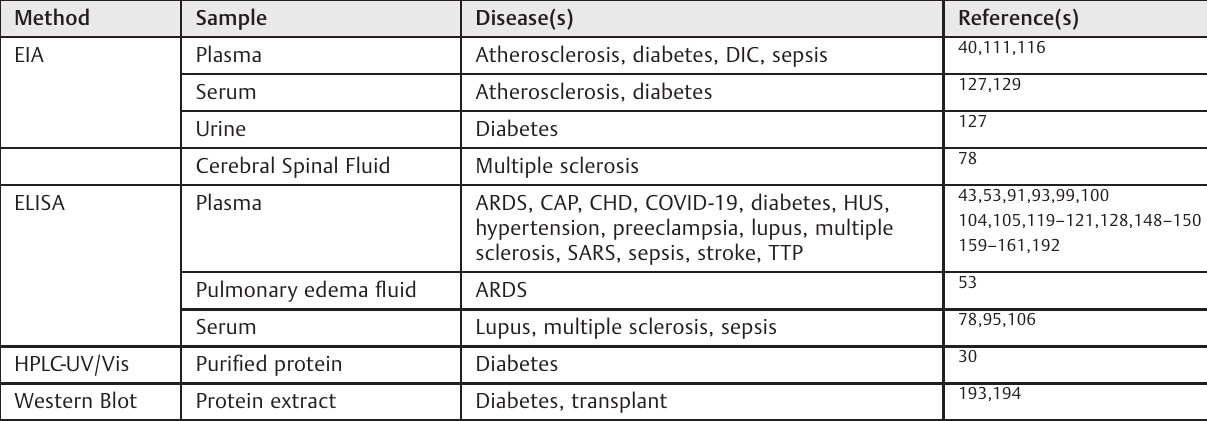
Table 2 Methods for measuring sTM in biological samples and diseases